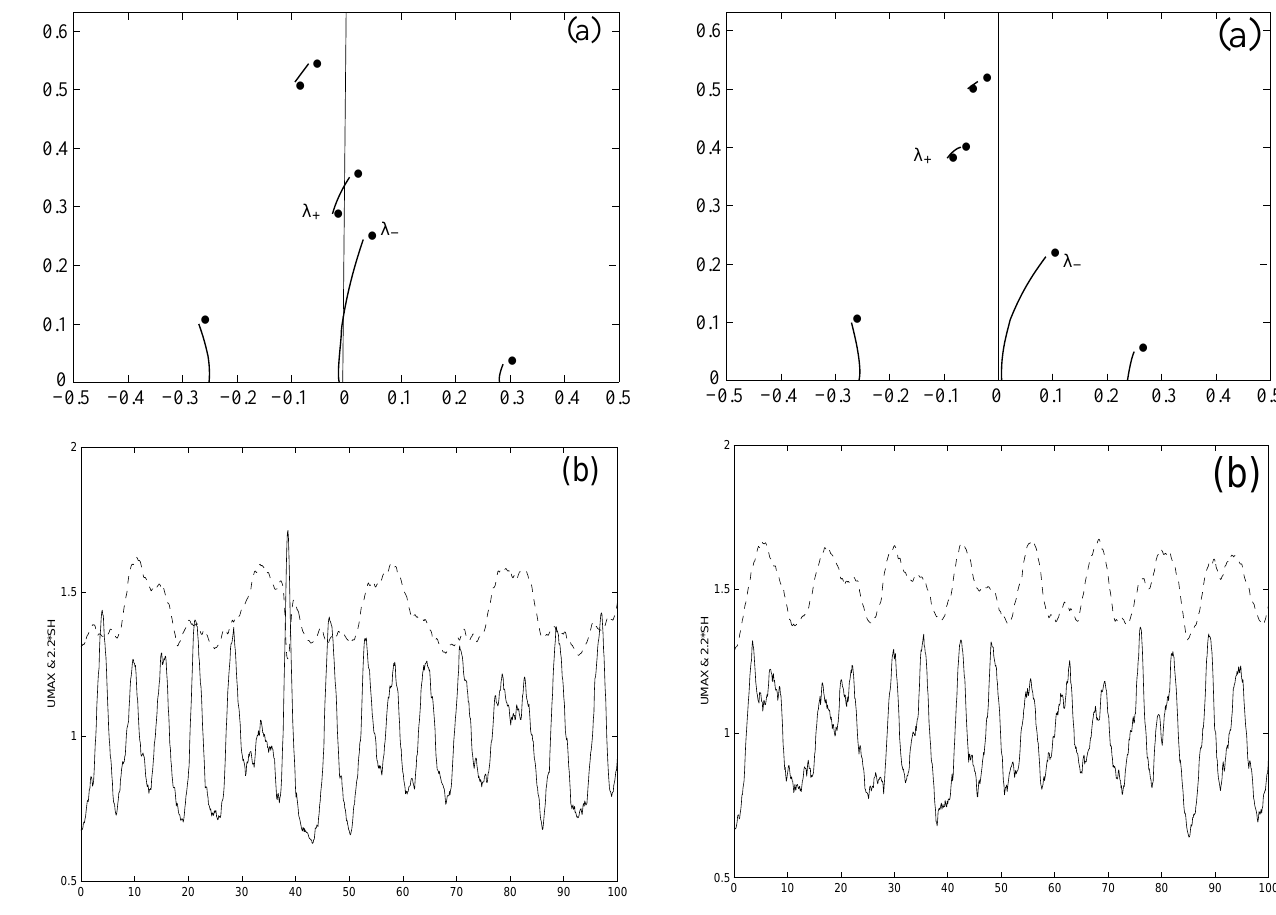
“far” from “far” from max max